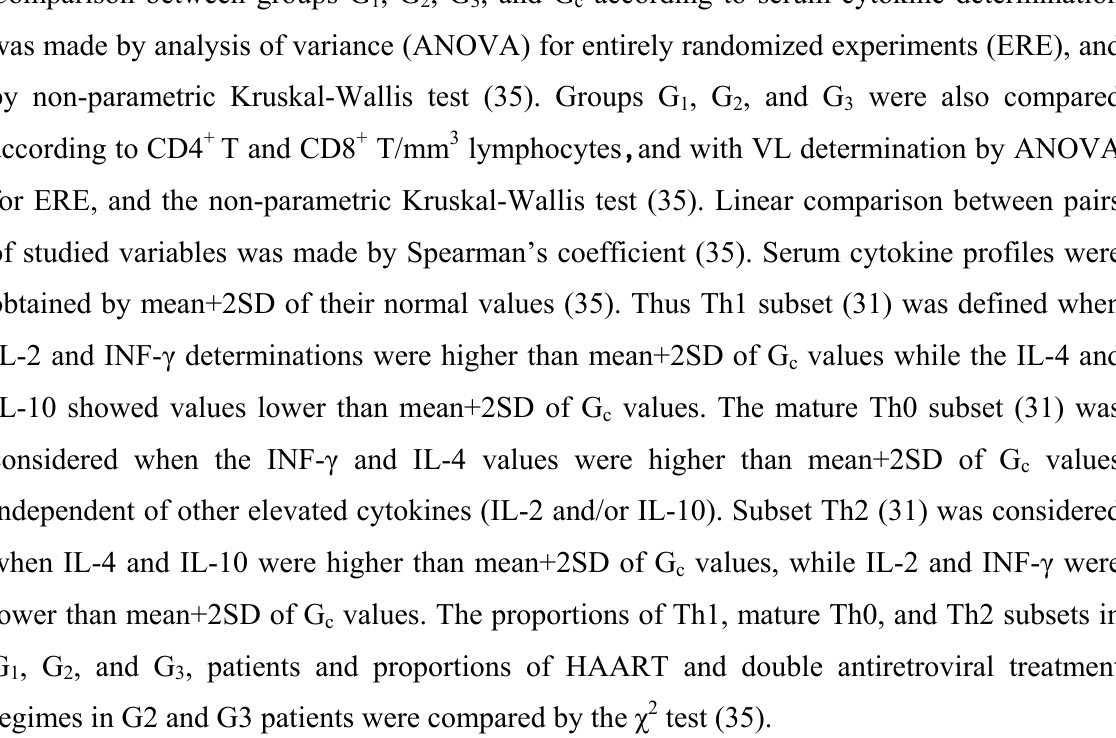
D. A. Meira et al . CORRELATION BETWEEN CYTOKINE SERUM LEVELS, NUMBER OF CD4 + T CELLS/mm³ AND VIRAL LOAD IN HIV-1 INFECTED INDIVIDUALS WITH OR WITHOUT ANTIRETROVIRAL THERAPY.